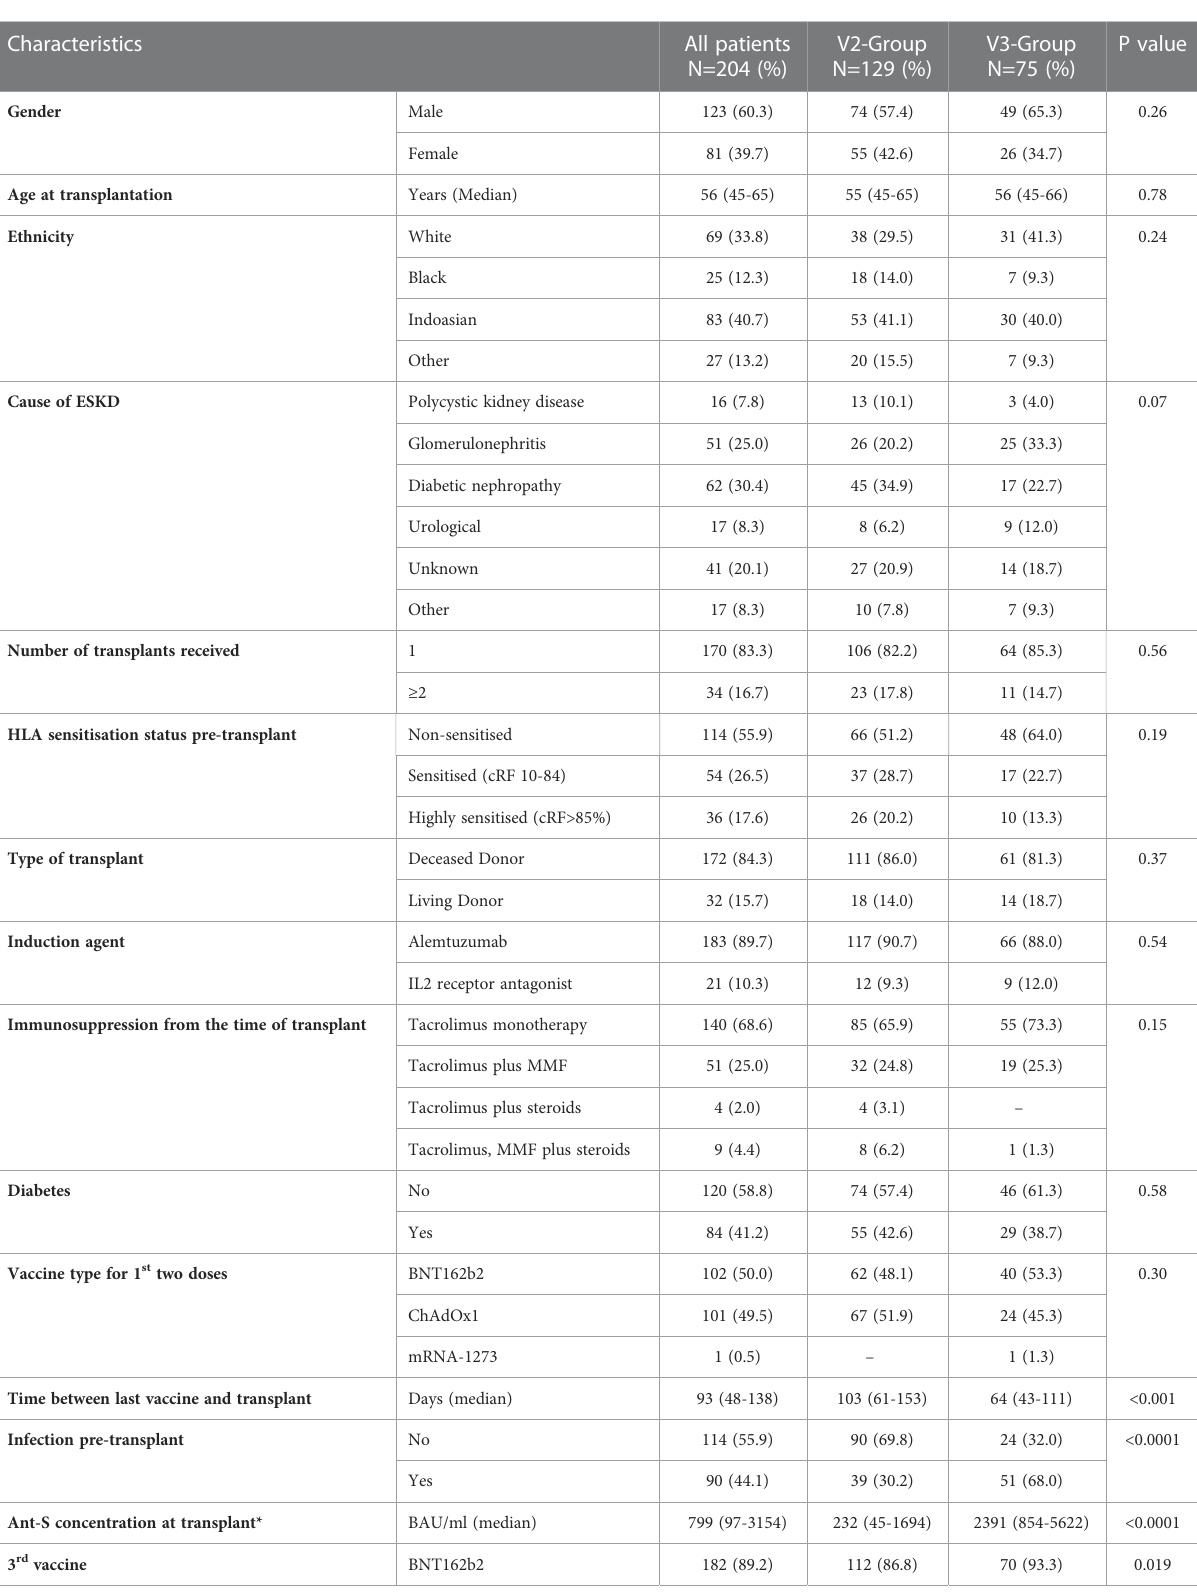
TABLE 1 Characteristics of transplant